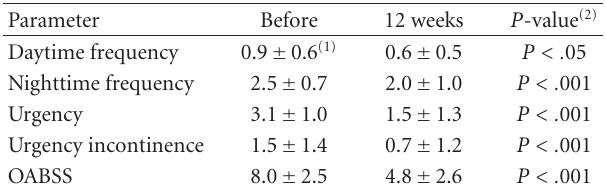
Table 2: Change in OABSS before and after solifenacin treatment ( n =